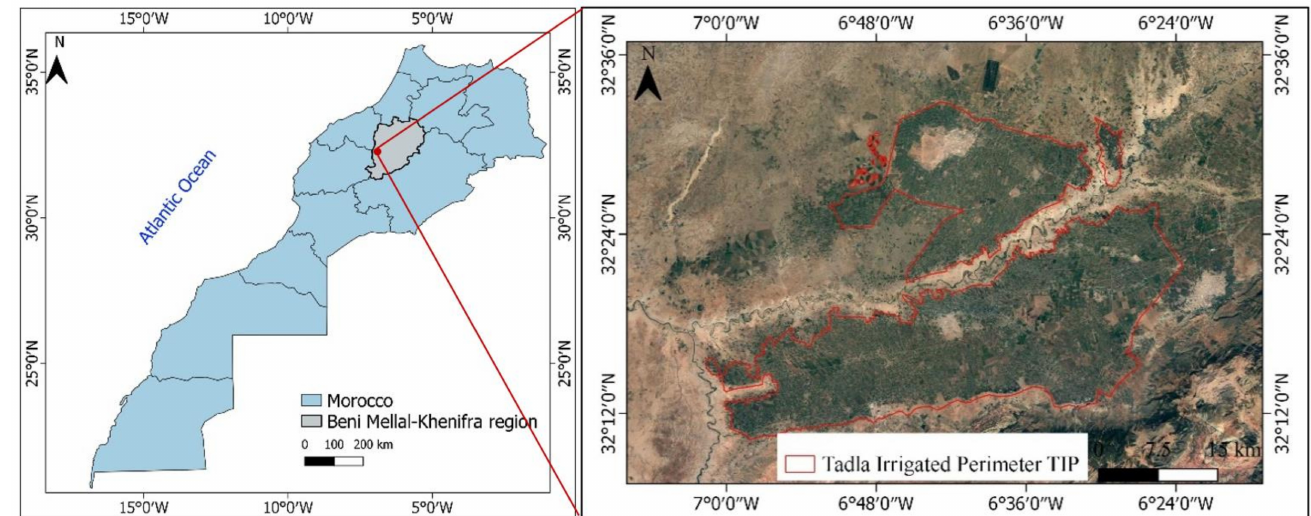
Figure 1. Location of the study area at the national scale ( left ). Scene of Tadla Irrigated Perimeter ( right